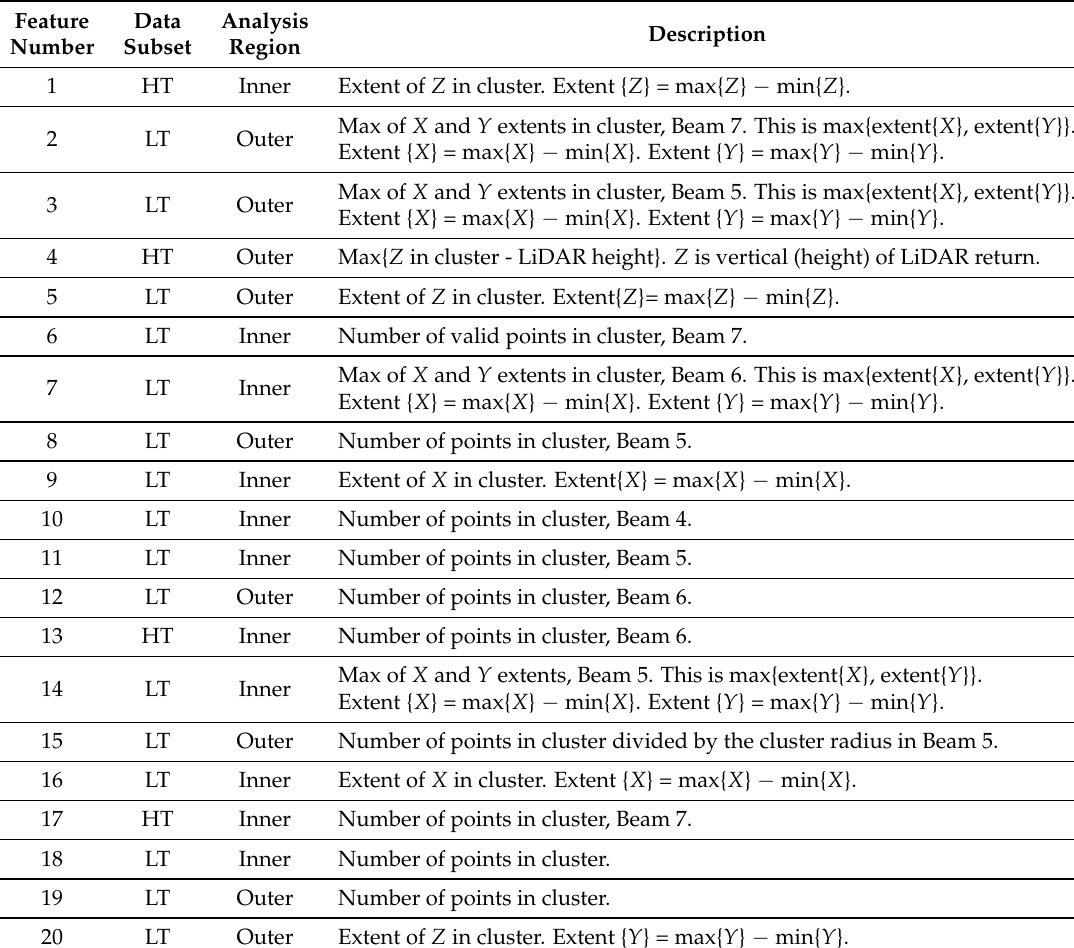
Table 1. Feature descriptions. Data subsets: HT = high threshold data. LT = low threshold data. The LiDAR rings are shown in Figure